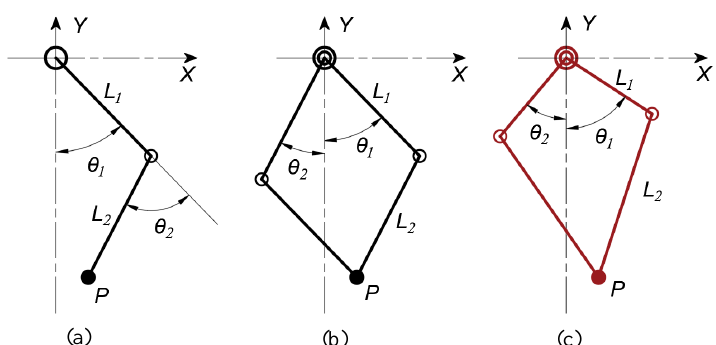
Figure 2. The three kinds of leg topology recruitment: ( a ) series articulated leg, ( b ) parallel planar leg, ( c ) symmetric leg.